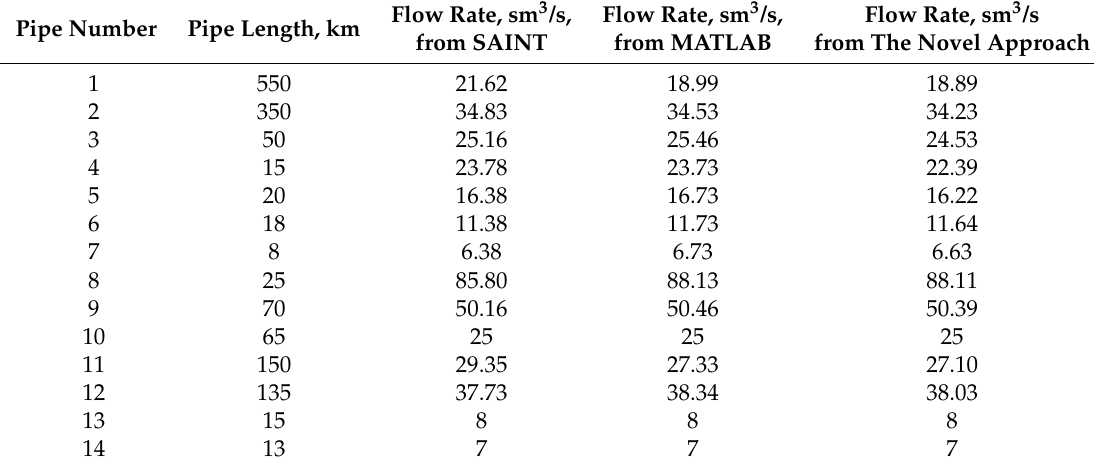
Table 4. Pipelines’ details with flow rate outputs through the pipes from SAINT, MATLAB, and the novel approach models.